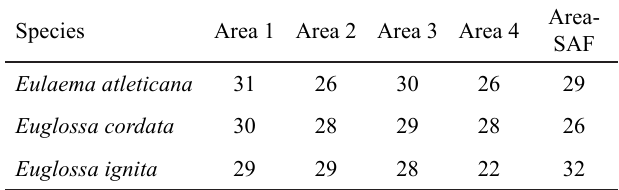
Table 2 . Number of individuals examined at each collection